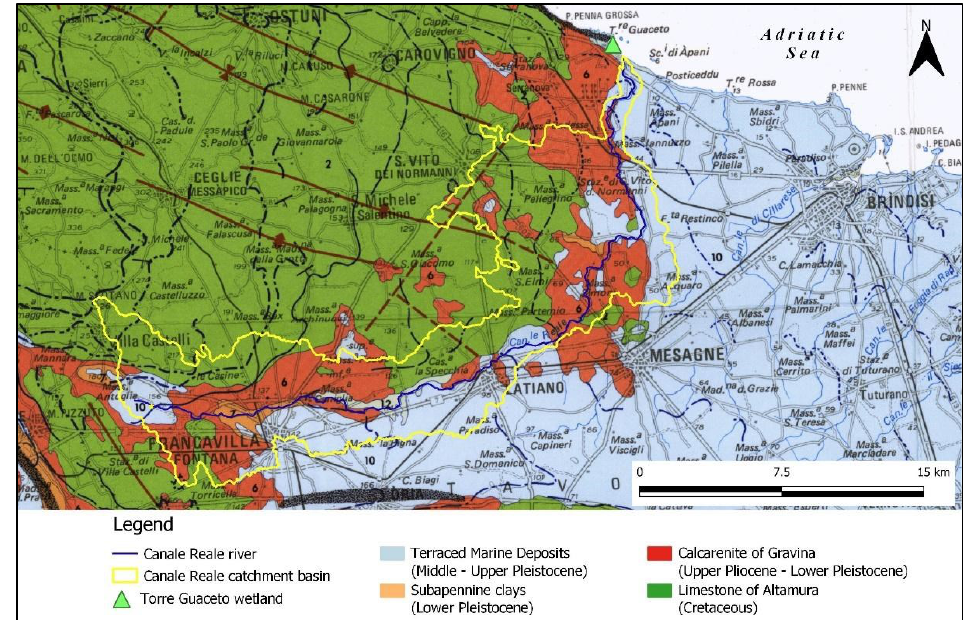
Figure 2. Geological map with a focus on the main formations outcropping in the Canale Reale catchment basin. catchment